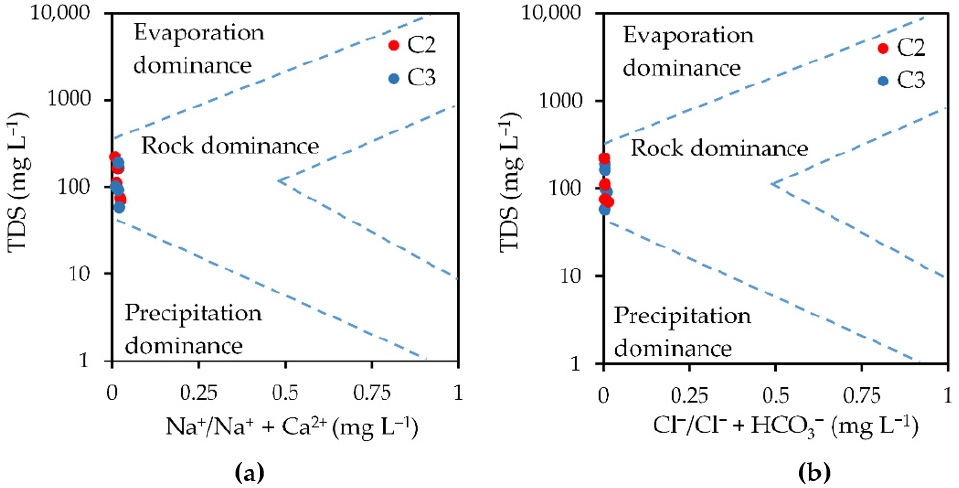
Figure 2. Gibbs diagram for Na + /Na + + Ca 2+ ( a ) and Cl − /Cl − + HCO 3 − ( b ) for the water samples collected from Clo ș ani Cave. C2—water samples collected from a small pool on the clayish floor; C3—water samples collected from a small pond on calcite.